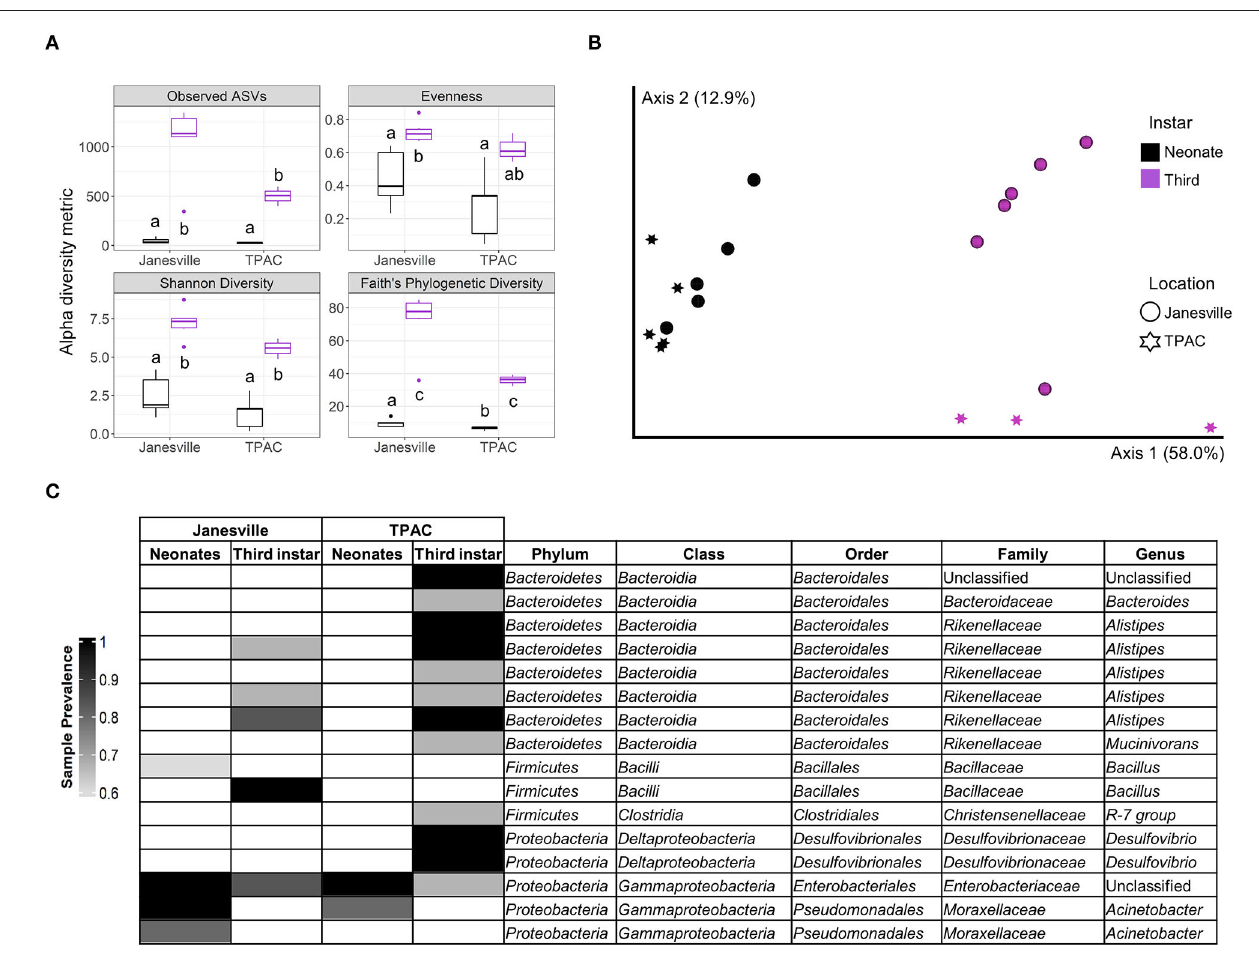
FIGURE 1 | Comparison of gut prokaryotic microbiota of neonates eclosing from surface-sterilized eggs and field-collected third instar Japanese beetle ( Popillia japonica Newman) larvae. Whole-gut microbial communities in neonates eclosed from surfaced sterilized eggs (black) were compared to the combined midgut and hindgut microbial communities in third instar larvae (purple) collected from the same locations. Variation in (A) α -diversity metrics (different letters mean statistically significant at α = 0.05, Kruskal–Wallis), (B) β -diversity, principal coordinate analysis for weighted UniFrac (PERMANOVA, pseudo-F 4,19 = 9.7, p = 0.001), and (C) core prokaryotic microbiota [amplicon sequence variants (ASVs) ≥ 0.01 relative abundance and sample prevalence ≥ 0.6] represented by a heatmap. All ASVs belonged to Bacteria